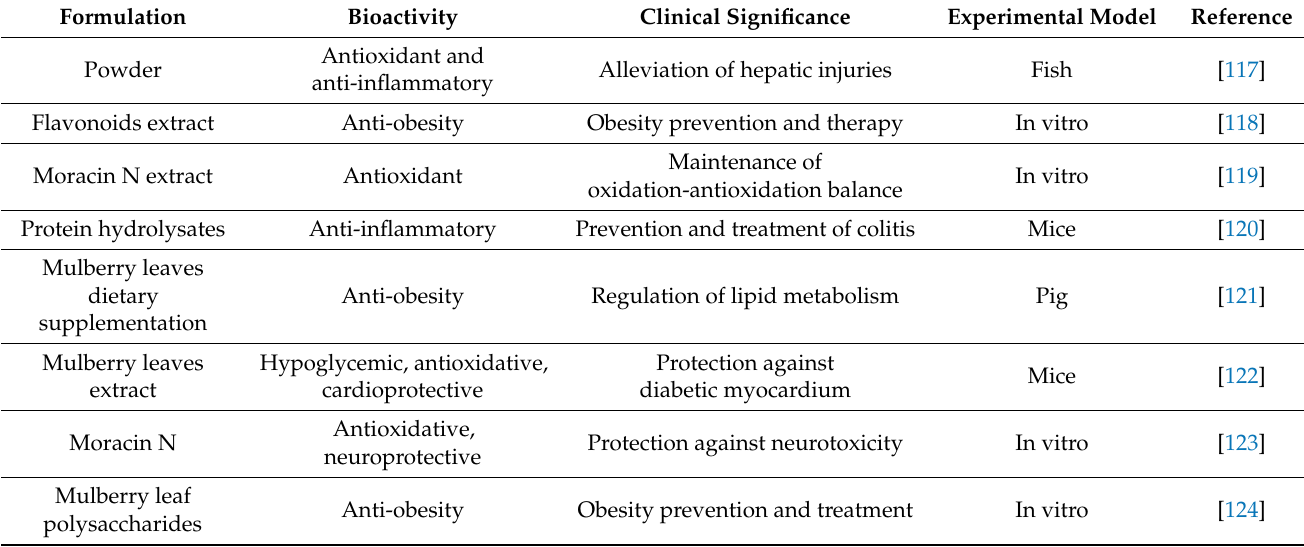
Table 2. Bioactivities of mulberry leaf extracts and their clinical